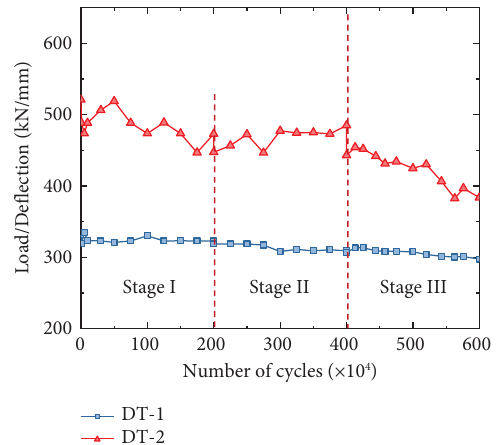
Figure 21: Evolution of local stifness at loading point.